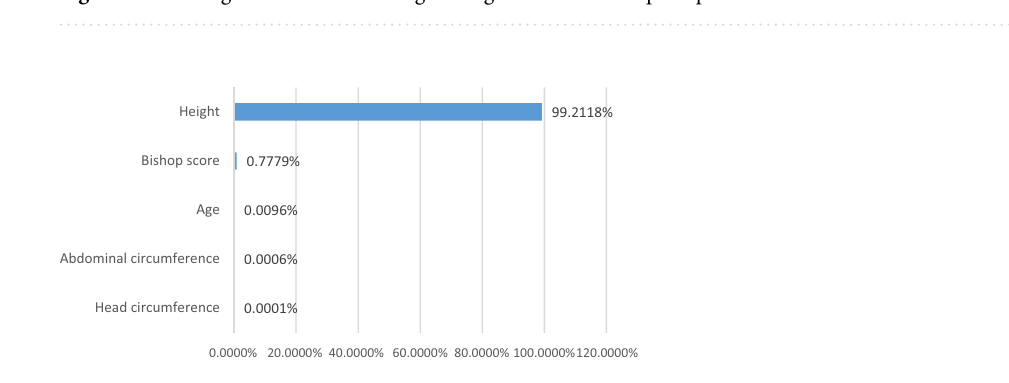
Figure 3. Ranking of the variables of logistic regression model of primiparas.